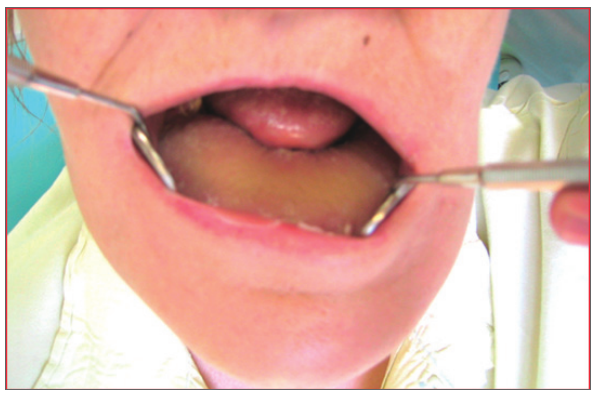
Fig. 4. Results after reconstruction of lower jaw and defect of soft tissue in floor of